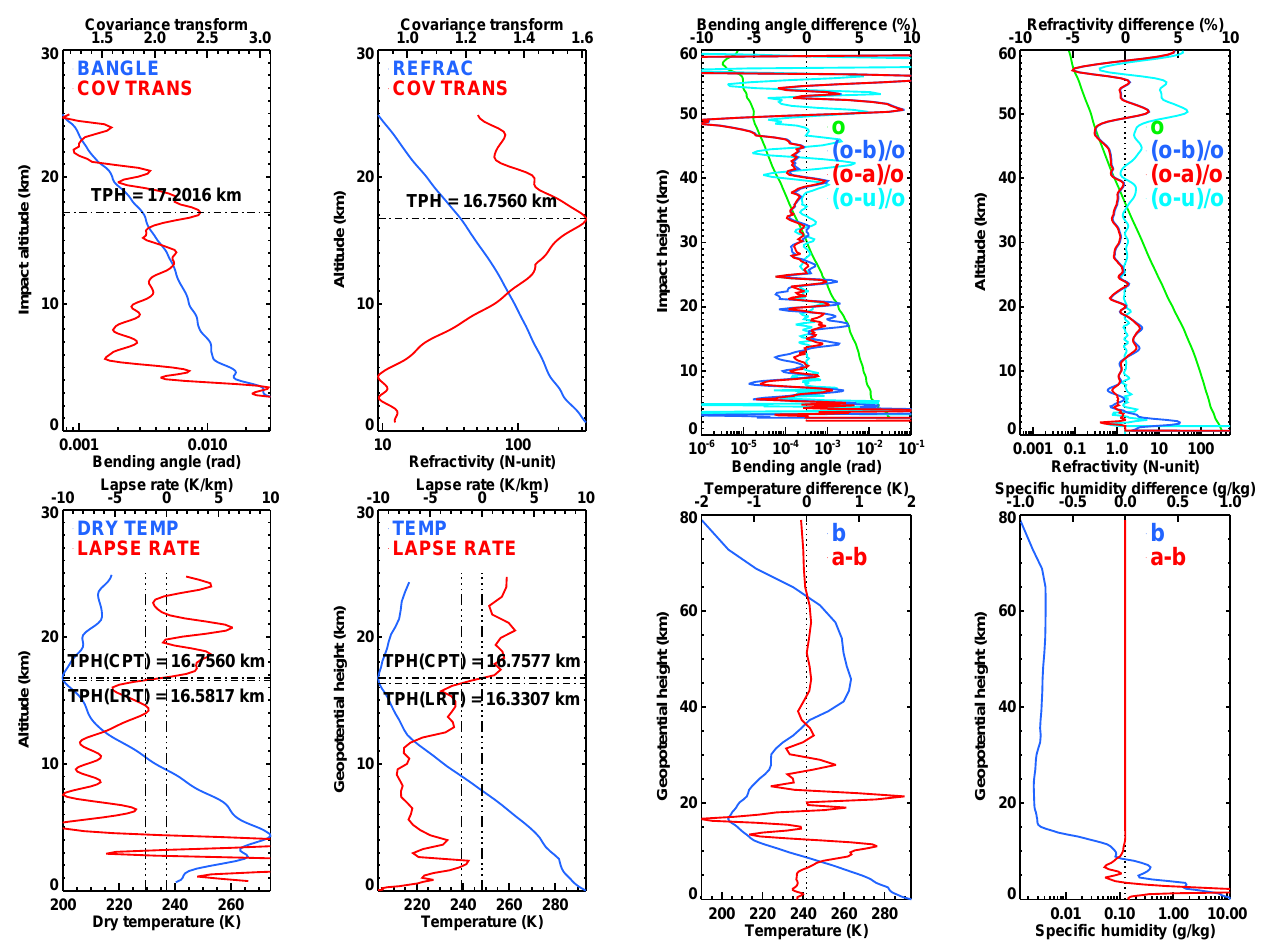
Figure 5. The results of passing COSMIC bending angles and refractivities, and the colocated/simultaneous ECMWF background fields, through ropp_1dvar_bangle and ropp_1dvar_refrac . Top left: observed bending angle profile o , as generated by ropp_pp_occ_tool (see Fig. 3), and its fractional difference from the background b and 1D-Var solution a , after forward modelling (effectively) by ropp_fm_bg2ro_1d . Also included: fractional difference to UCAR-generated bend- ing angle u . Top right: same but for refractivity. Bottom left: background temperatures, as generated by grib2bgrasc and bgrasc2ropp (see Fig. 3), and the difference from the solution temperatures, as returned by ropp_1dvar_bangle . Bottom right: as bottom left but for specific